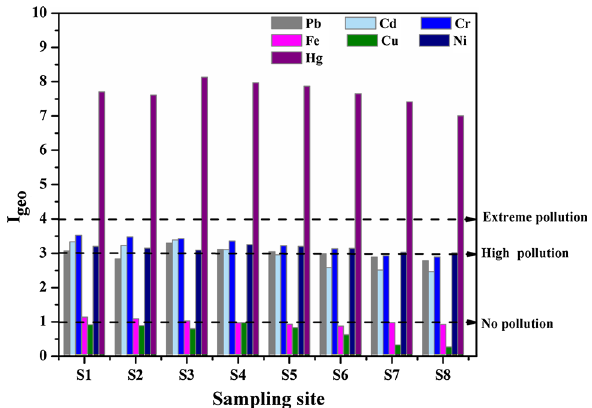
Fig. 2 Geo-accumulation index ( I samples in various sampling sites